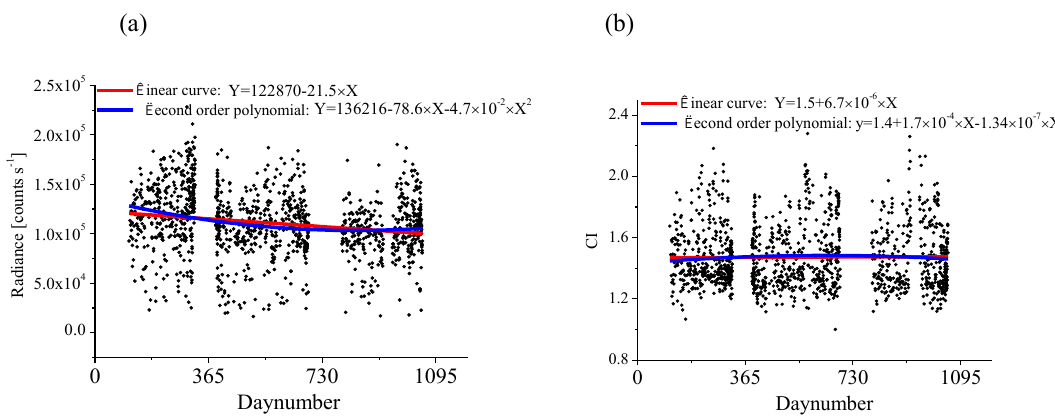
Figure 2. The radiance at 380nm (a) and the color index (340/420nm) (b) derived from MAX-DOAS observations in zenith view against the day number (the day number of 1 corresponds to 1 January 2011) for an SZA interval of 49 to 51 ◦ . The red and blue curves represent a linear fitted slope and second-order polynomial as functions of the day number,